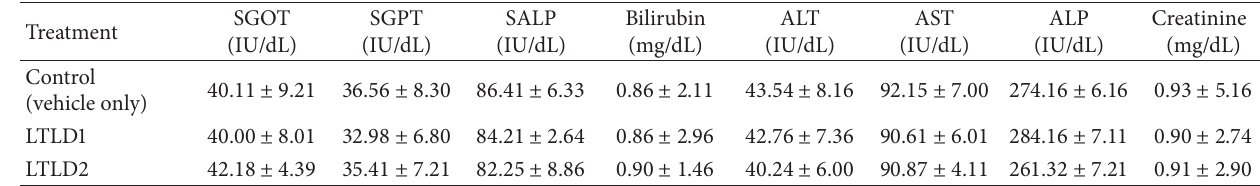
Table 1: Effect of LTL treatment on serum biochemical parameter of mice.